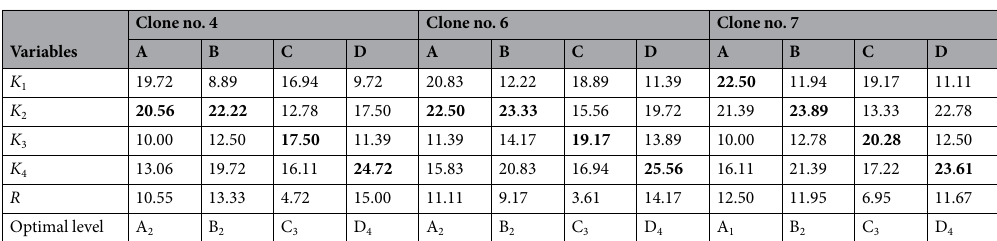
Table 3. Range analysis of L 16 (4) 4 test results for rooting rate. The optimal level is in bold.